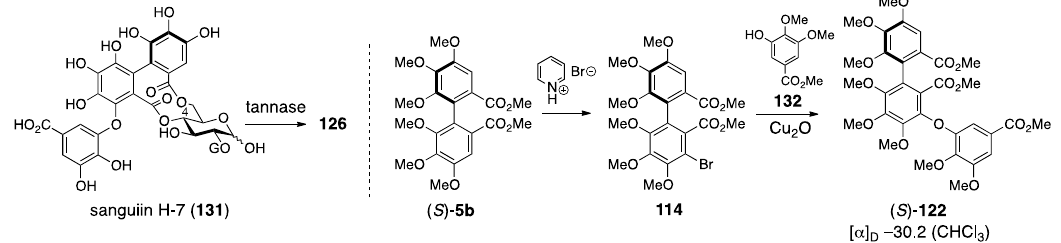
Figure 46. The information referred to in the structural revision to 116 .